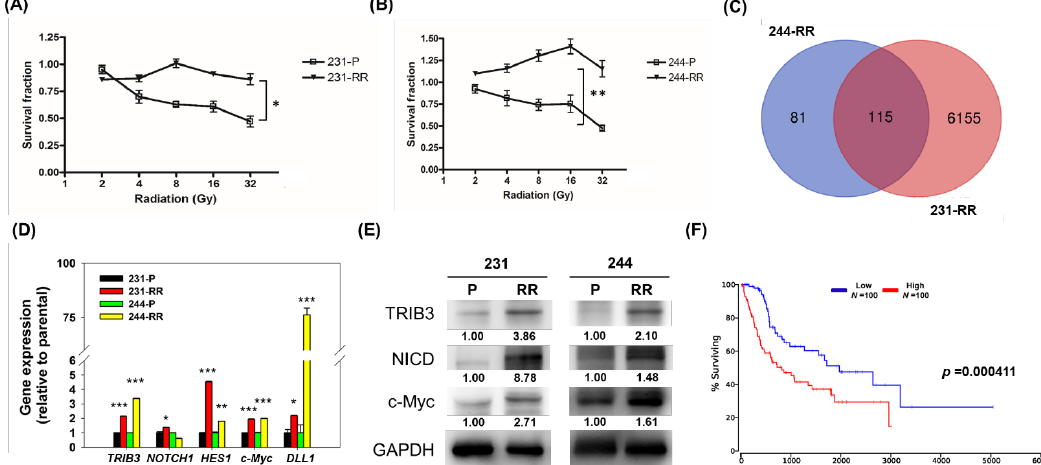
Figure 1. Tribbles pseudokinase 3 (TRIB3) expression and Notch1 activation were increased in radioresistant triple negative breast cancer (TNBC) cells. ( A , B ) MDA-MB-231, ( A ) AS-B244, ( B ) TBNC cells were repeatedly exposed to 2 Gy radiation for 10 cycles. The comparison of radiosensitivity